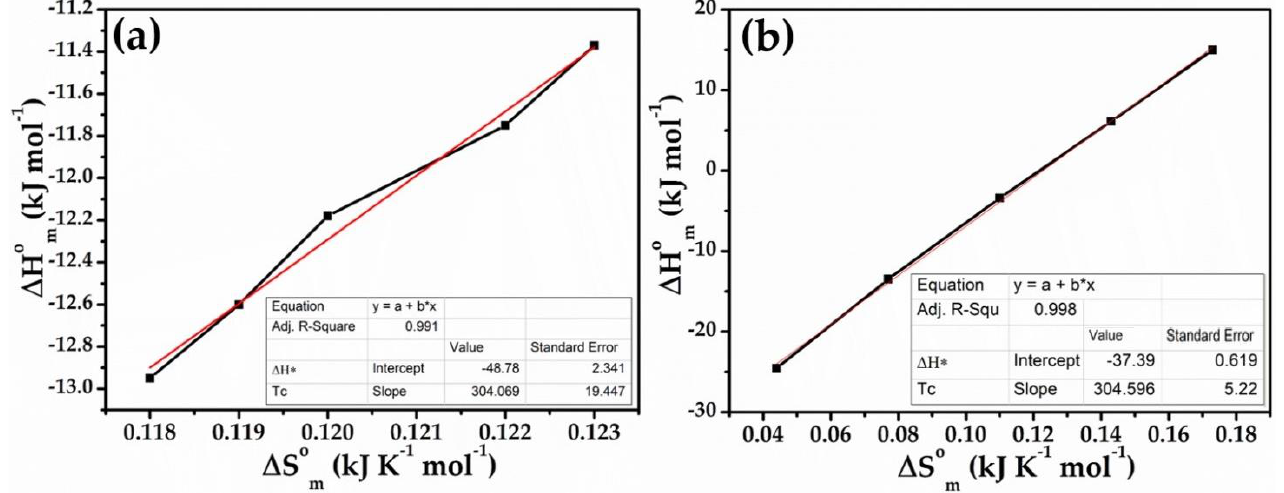
Figure 5. Descriptive plots for enthalpy-entropy compensation of ( a ) NaC and ( b ) NaDCin 0.010 mol∙kg − 1 aqueous glycyl dipeptide.